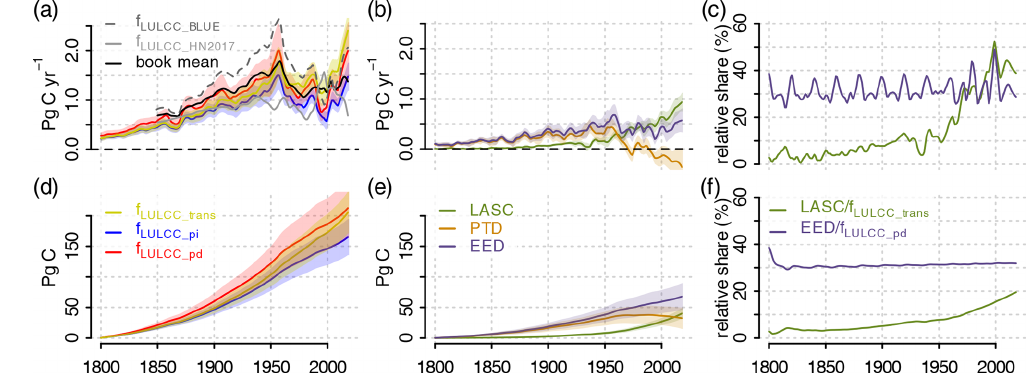
Figure 2. Multi-model means of smoothed global annual values (a–c) and cumulative sums (d–f) of f LULCC estimates (a, d) , the loss of additional sink capacity (LASC; b, c ), the “present-day” vs. “transient” environmental conditions difference (PTD; b, c ), the environmental equilibrium difference (EED; b, c ), and the relative contributions of the LASC and EED to f LULCC_trans and f LULCC_pd respectively (c, f) from 1800 to 2018. Additionally, the f LULCC from the bookkeeping models BLUE and H&N2017 as well as their average is plotted (data for GCB2019; not shown for cumulative sums due to shorter data coverage). For absolute values from this study, the 95% confidence intervals are also shown. See Figs. 3 and 4 for an individual model’s results for f LULCC estimates and their differences,